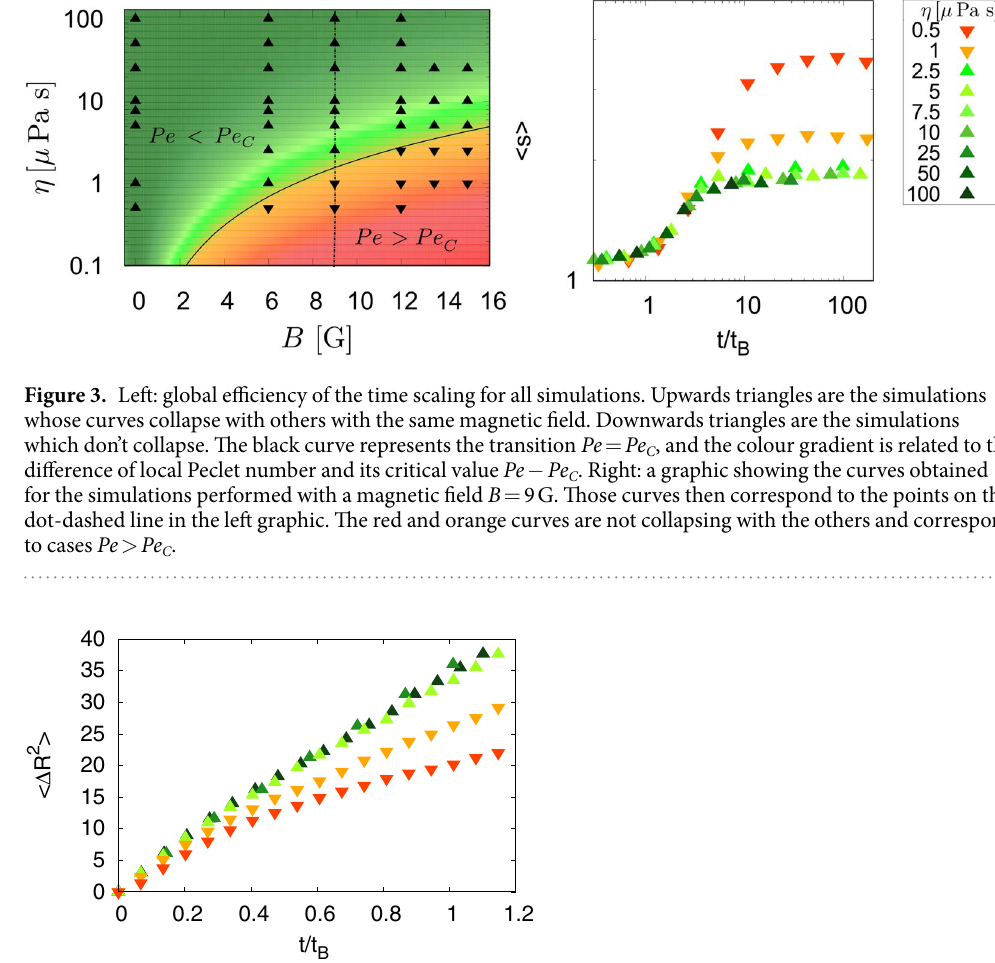
Figure 4. Mean Square displacement of the particles in the horizontal plane as a function of dimensionless time. The mean square displacement is expressed in particles diameter and the time has been scaled by the aggregation characteristic time t B (equation (3)) to compare curves from various simulations under a magnetic field of 9 G. All the curves corresponding to points in the region Pe < Pe C collapse, while curves in the region Pe > Pe C have a different